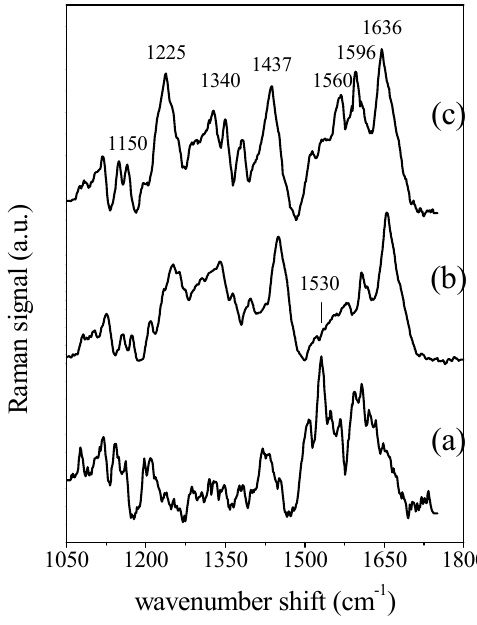
Figure 5. Raman spectra of oral tissue biopsies from PV affected patients (a) , patients under drug therapy (b) and patients in the remission stage of illness (c) in the wavenumber range 1,050–1,700 cm − 1 .